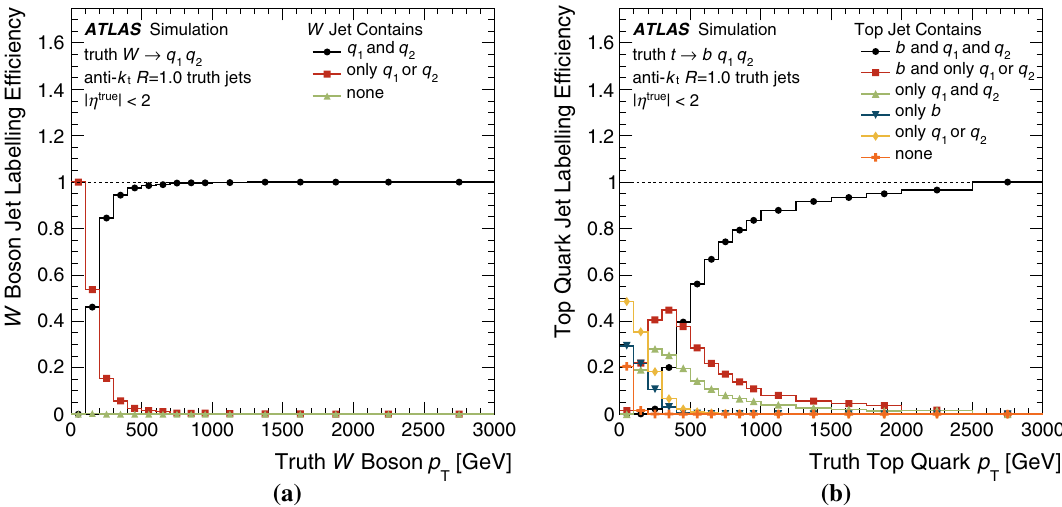
Fig. 1 Containment of the W -boson ( a ) and top-quark ( b ) decay products in a single truth-level anti- k t R = 1 . 0 jet as a function of the particle’s transverse momentum the jet axis, serves as a strong motivation for the various optimisation strategies described in Sect.